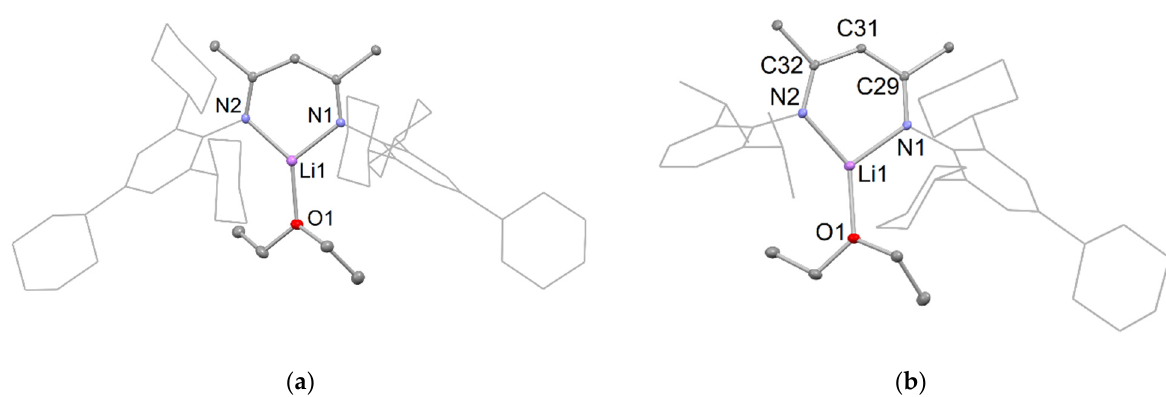
Figure 2. ( a ) Partial thermal ellipsoid plot (25% probability surface for displayed ellipsoids) of the molecular structure of 4 (hydrogen atoms omitted; TCHP groups shown as wireframe for clarity). Selected bond lengths (Å) and angles (°): Li(1)-O(1) 1.953(4), N(1)-Li(1) 1.921(4), N(2)-Li(1) 1.924(4), N(1)-Li(1)-N(2) 97.67(18); ( b ) thermal ellipsoid plot (25% probability surface) of the molecular structure of 5 (hydrogen atoms omitted; Dip and TCHP groups shown as wireframe for clarity). Selected bond lengths (Å) and angles (°): Li(1)-O(1) 1.975(4), N(1)-Li(1) 1.927(4), N(2)-Li(1) 1.935(4), N(1)-Li(1)-N(2) 97.79(17) .